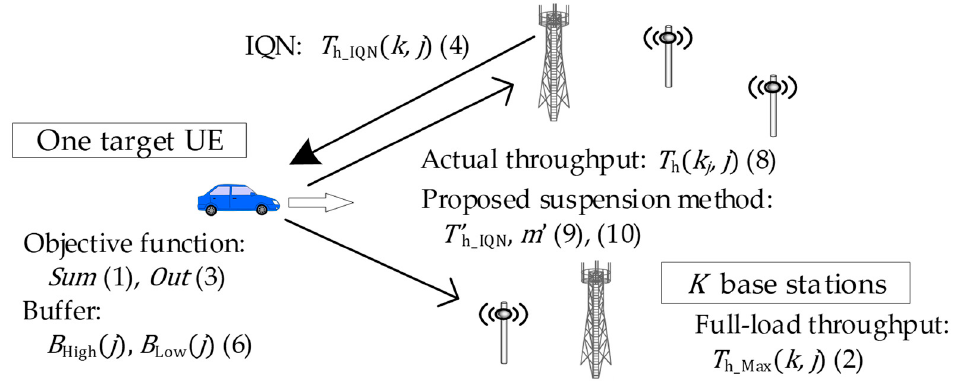
Figure 2. Overview of proposed algorithm with main parameters.